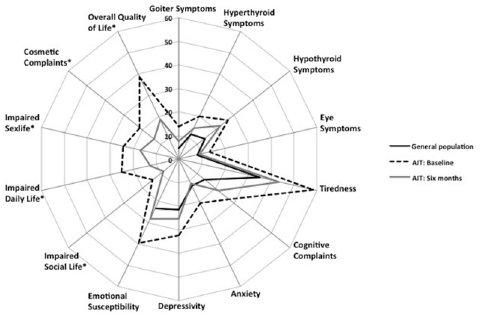
Fig 1. ThyPRO radar plot. Radar plot showing ThyPRO scale scores for patients with autoimmune hypothyroidism (AIT) at baseline and 6-months follow-up as well as scores from the general population sample. Each scale ranges 0 – 100, with higher scores indicating poorer quality of life. Items in ThyPRO scales marked * are asked with attribution to thyroid disease and cannot be answered by respondents from the general